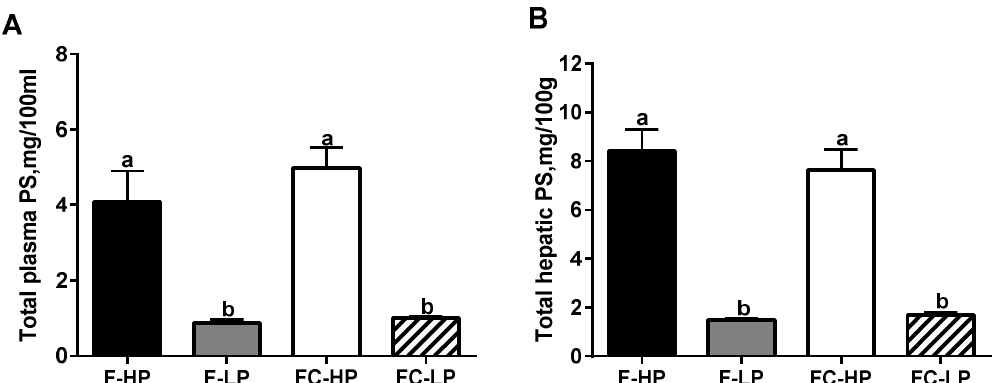
Figure 1. Total PS concentrations in plasma ( A ) and liver ( B ) of piglets fed different infant formulas containing high (F-HP) or low (F-LP) PS concentrations, supplemented with cholesterol (FC-HP, FC-LP) to achieve concentrations similar to human milk. Data are means ± Standard error of the mean (SEM), n = 8/diet group. Statistical differences were determined by two-way ANOVA; for total plasma PS, p < 0.001 for PS, p = 0.360 for cholesterol, and p = 0.427 for interaction; for total hepatic PS, p < 0.001 for PS, p = 0.305 for cholesterol, and p = 0.407 for interaction; Student Newman-Keuls post hoc analysis. Bars without a common letter significantly differ from each other, p < 0.05.